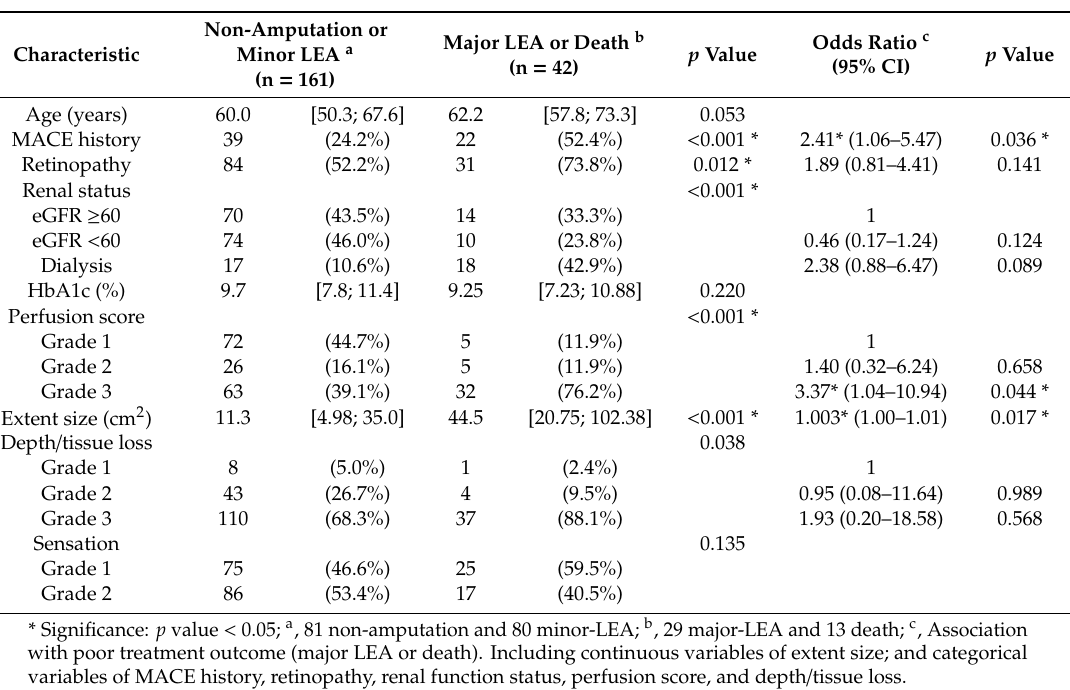
Table 2. Factors analysis for prognosis in patients with SIRS.